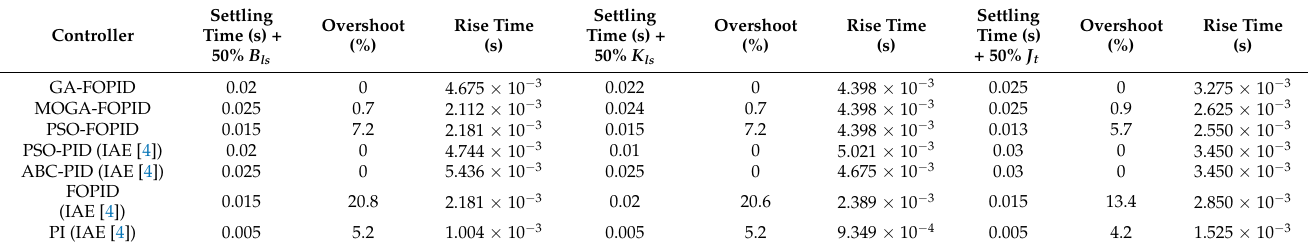
Table 8. The effects of system parameter uncertainties on controller performance.